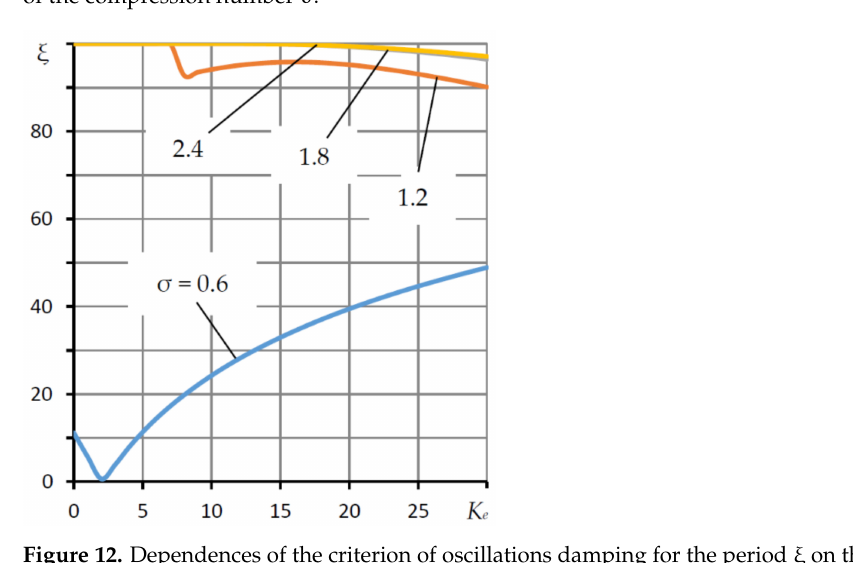
Figure 12. Dependences of the criterion of oscillations damping for the period ξ on the coefficient of elasticity K e for different values of the compression number σ